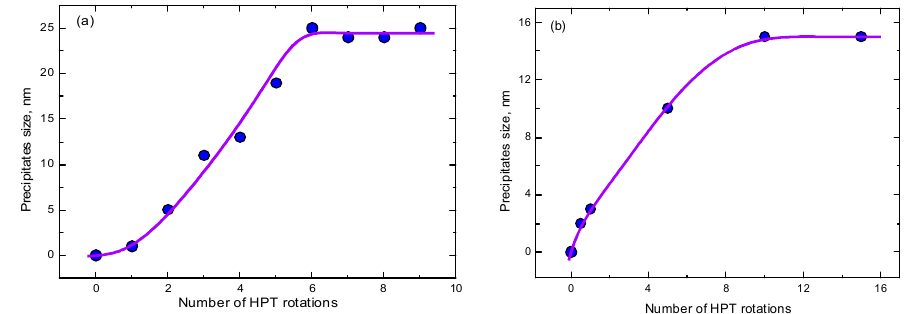
Figure 13. The dependence of size of nanocrystals ( a ) in the Fe 53.3 Ni 26.5 B 20.2 amorphous alloy estimated from the data published in ref. [106] and ( b ) in the Ti 50 Ni 25 Cu 25 amorphous alloy estimated from the data published in Refs. [107,108] on the number of HPT rotations. The lines are the guides for the eye.